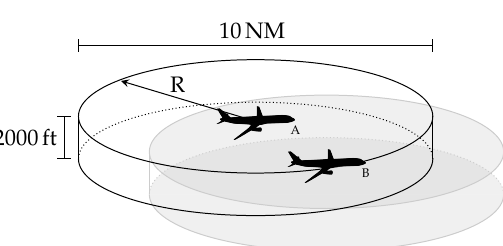
Figure 4. Different types of avoidance planning.